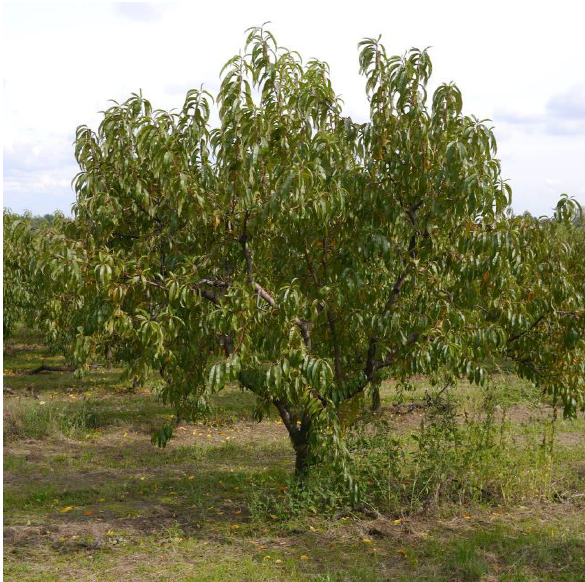
Figure 1. A peach tree in the test orchard during a leafy period Two test periods were selected: September 2017 and